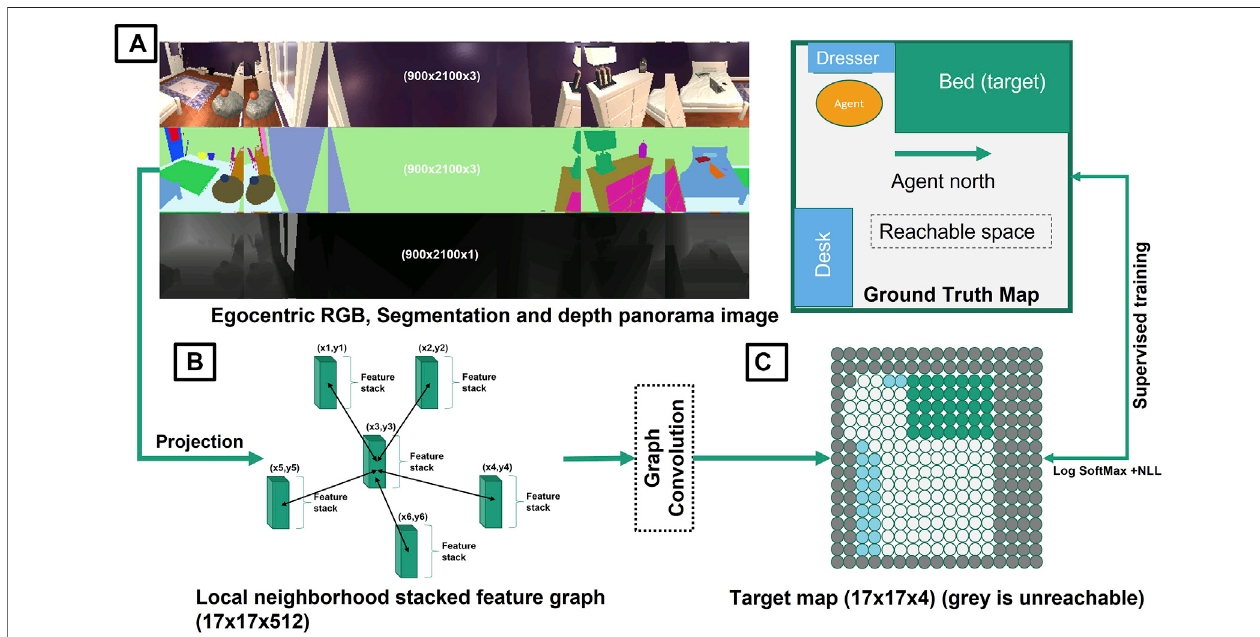
FIGURE5| Schematicofmappingusinggraphconvolution: (A) theagentobtainsinputpanoramaimagesinRGB,segmentationanddepthmodalitiestoconstruct a birds eye view (BEV) projection map of objects of interest around the agent using geometric transforms with camera intrinsic parameters (e.g., Bed (green), Dresser (lightblue),andDesk(blue)andthenavigablespace(white)arethesemanticobjectsofinteresthere). (B) Supervisedtrainingisusedwiththehelpofatruemap(obtained by placing agent at each position in the room) for a select few rooms and agent locations. (C) the initial projection gets re fi ned using a trained graph convolution network. Each grid node represents 0.25 × 0.25 m